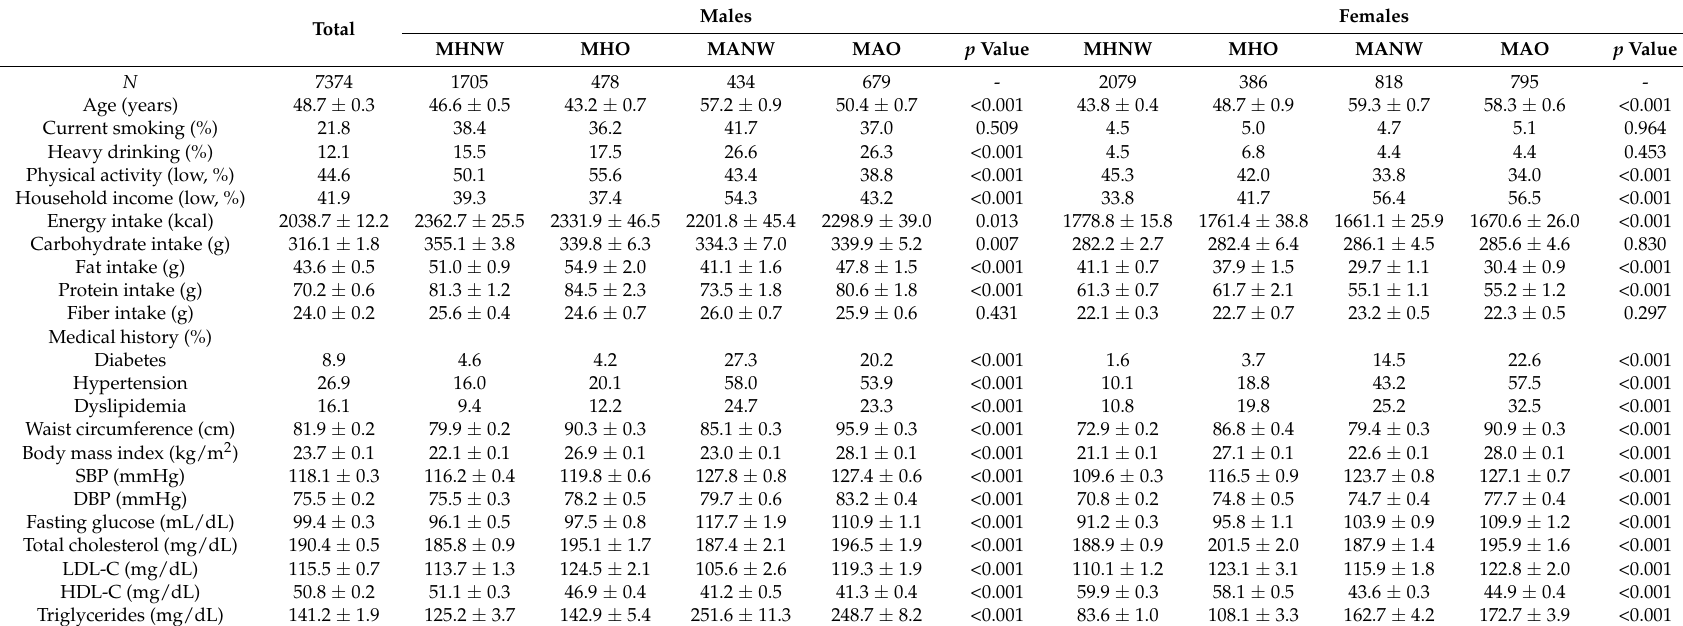
Table 1. Characteristics of study participants by obesity/metabolic risk